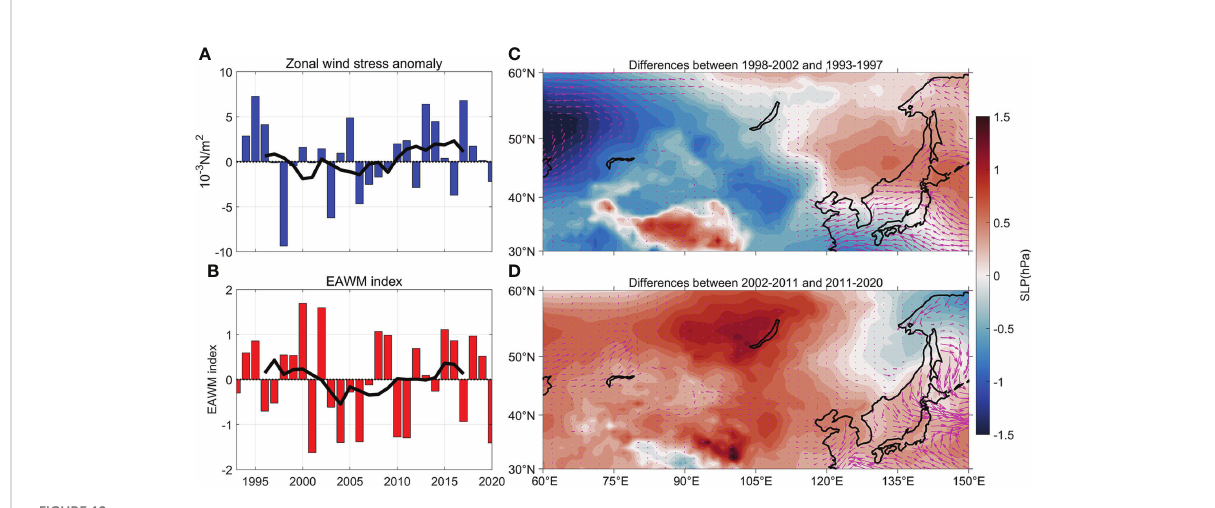
FIGURE 12 (A) Time series of basin-averaged zonal wind stress anomaly (unit: N/m 2 ) for the annual mean (blue bars) and seven-year running averages (black solid line). (B) Same as (A) but for the time series of EAWM index. (C) Decadal change in the SLP and wind stress vectors between the time periods 1993 – 1997 and 1998 – 2002 (the latter minus the former; unit: hPa and N/m 2 ). (D) Same as (C) but for the change in the time periods 2002 – 2011 and 2011 – 2020.